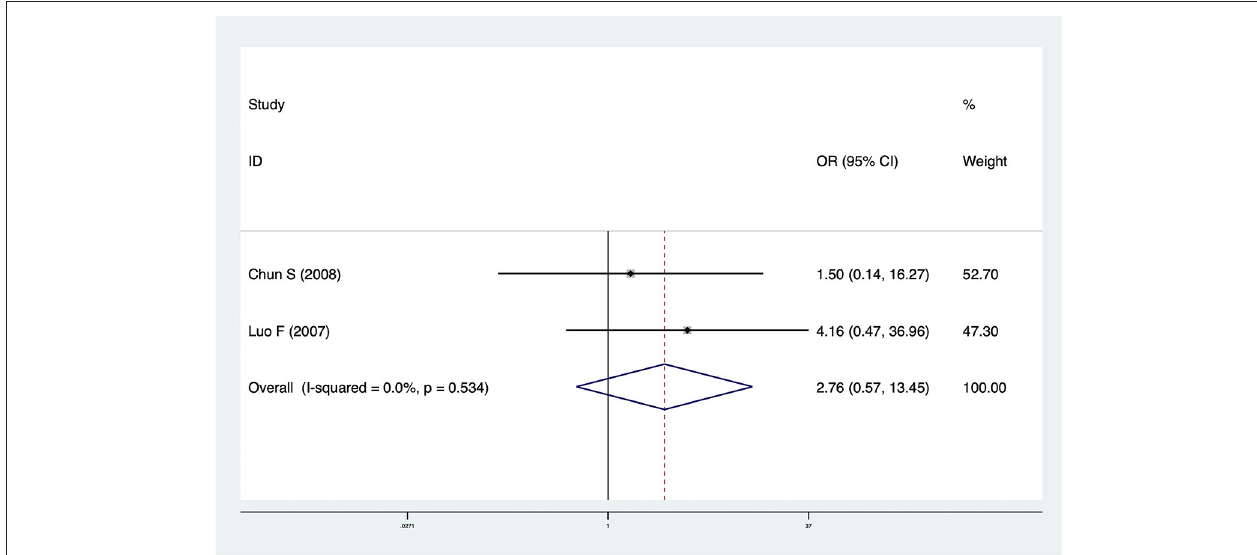
FIGURE 3 | Forest plot of incidence of cholangitis in CMV + BA vs. CMV − BA.